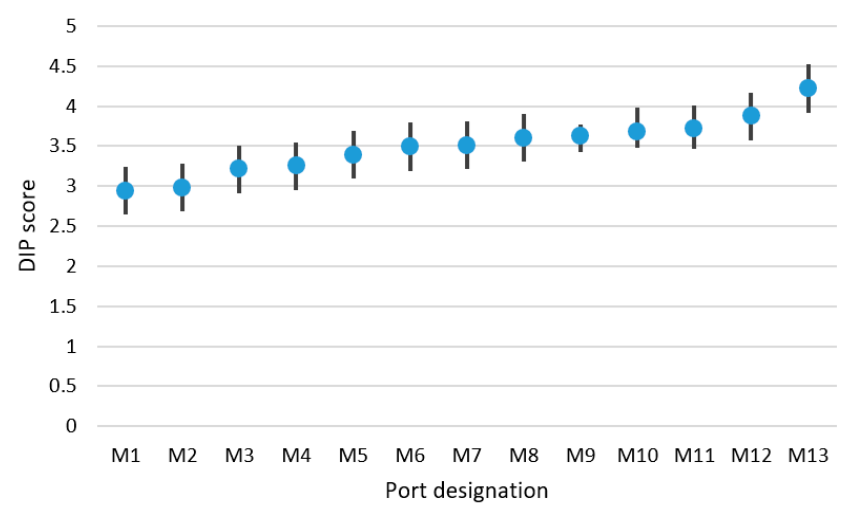
Figure 5. Medium-sized ports DIP score and DIP scoring band.